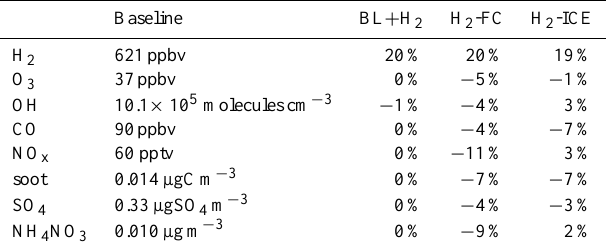
Figure 2. CAM-Chem simulated 2050 annual-mean ground-level H Fig. 2. CAM-Chem simulated 2050 annual-mean ground-level H 2 mixing ratios in the A1FI (a) and B1 (c) baseline scenarios and the percent differences for the A1FI (b) and B1 (d) H 2 -FC scenarios. Note the different scales. (a) and B1 (c) Baseline scenarios and the percent differences for the A1FI (b) and B1 (d) H -3 FC scenarios. Note the different scales. 4 Table 2. Tropospheric mean mixing ratios or concentrations for the 2050 B1 baseline scenario and percent changes for the baseline + H 2 (BL + H 2 ) , hydrogen fuel cell (H 2 -FC), and hydrogen internal combustion engine (H 2 -ICE) scenarios from the CAM-Chem model